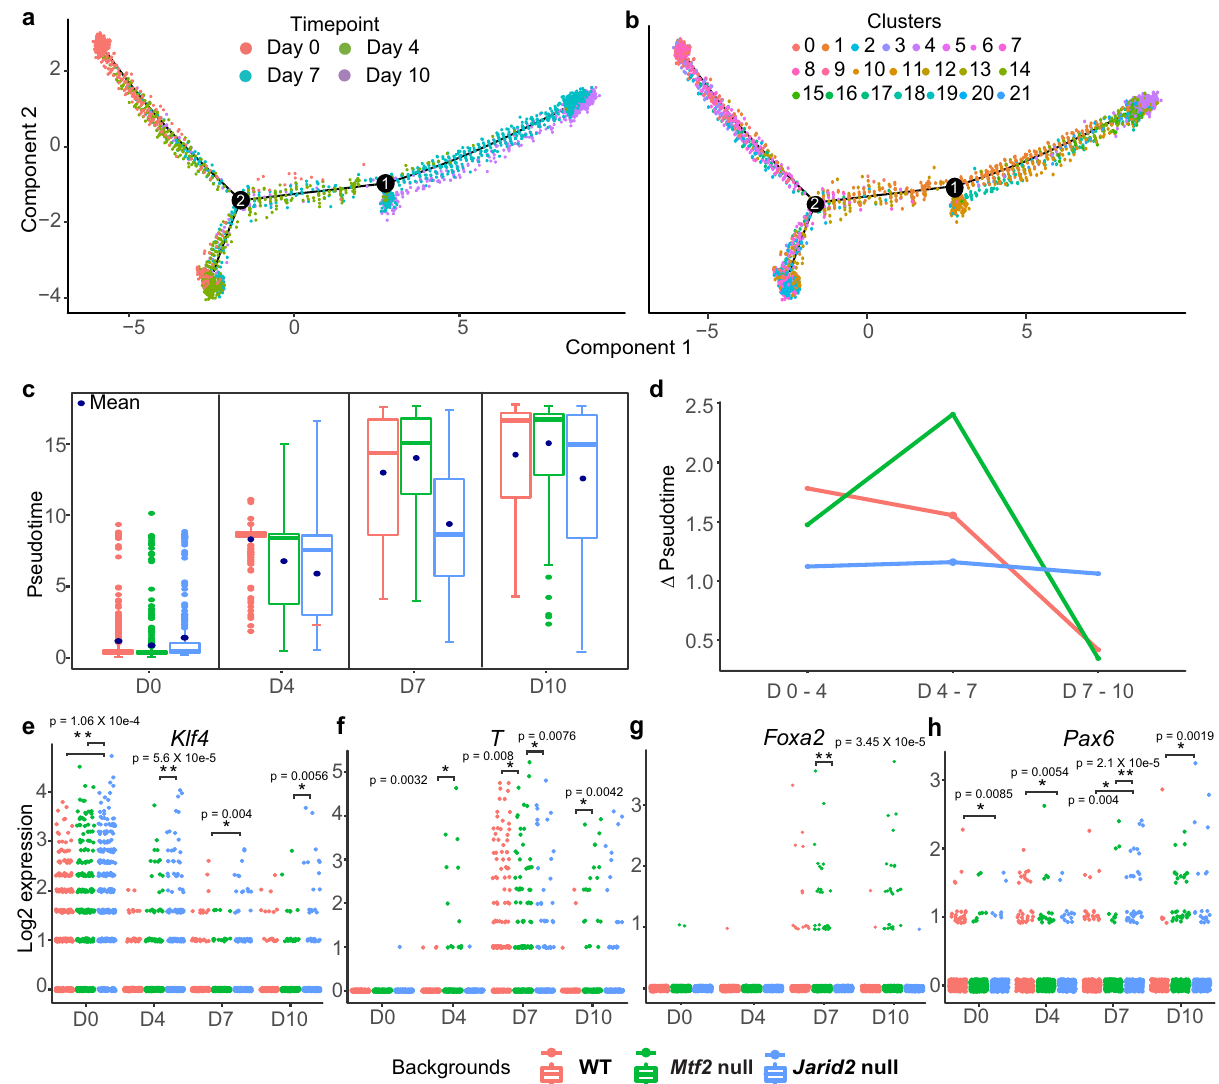
Fig. 3 Mtf2 null cells progress faster through mid-differentiation than WT and Jarid2 null cells. a Trajectory plot of all cells ordered along pseudotime. Two branching points were shown (numbered) along the plot. b Same trajectory plot as ( a ) but overlaid with cluster identity of individual cell. c Boxplots for each time point showing the pseudotime values of cells from different genetic backgrounds. No. of cells for each time point and background can be found in Supplemental Table 1. Dark blue dots represent the mean. Whisker ends of boxplot represent the maximum (top) and minimum values, respectively. Top and bottom of boxplots represent 75th and 25th percentile values, respectively, and fi nally, median values are shown as colored lines within the boxplots. d Delta pseudotime plot, showing the distance (change in mean pseudotime value) per unit of time (days) between different genetic backgrounds. e – h Log2 expression values for selected lineage genes at different time points; comparing between different genetic backgrounds. Each dot represents a single cell. Signi fi cant differences (Wilcoxon signed-rank test, two-sided alternative hypothesis testing) are indicated: * p -value < 0.01, ** p - value <1 × 10 − 4 . No. of cells for each time point and background can be found in Supplemental Table